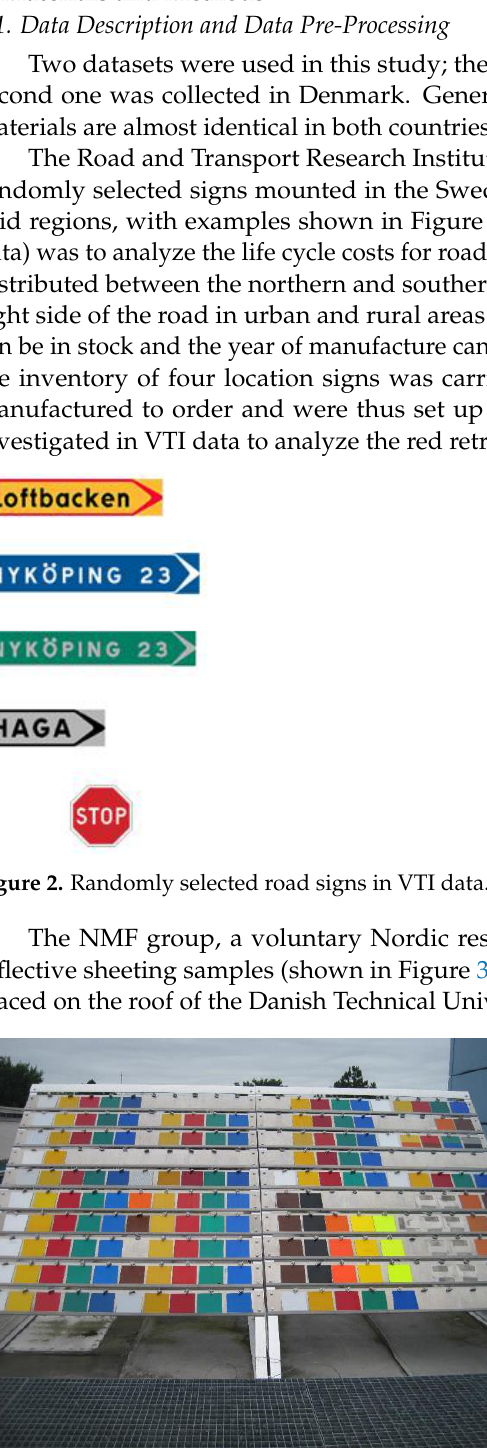
Figure 3. Reflective sheeting samples in the NMF data.